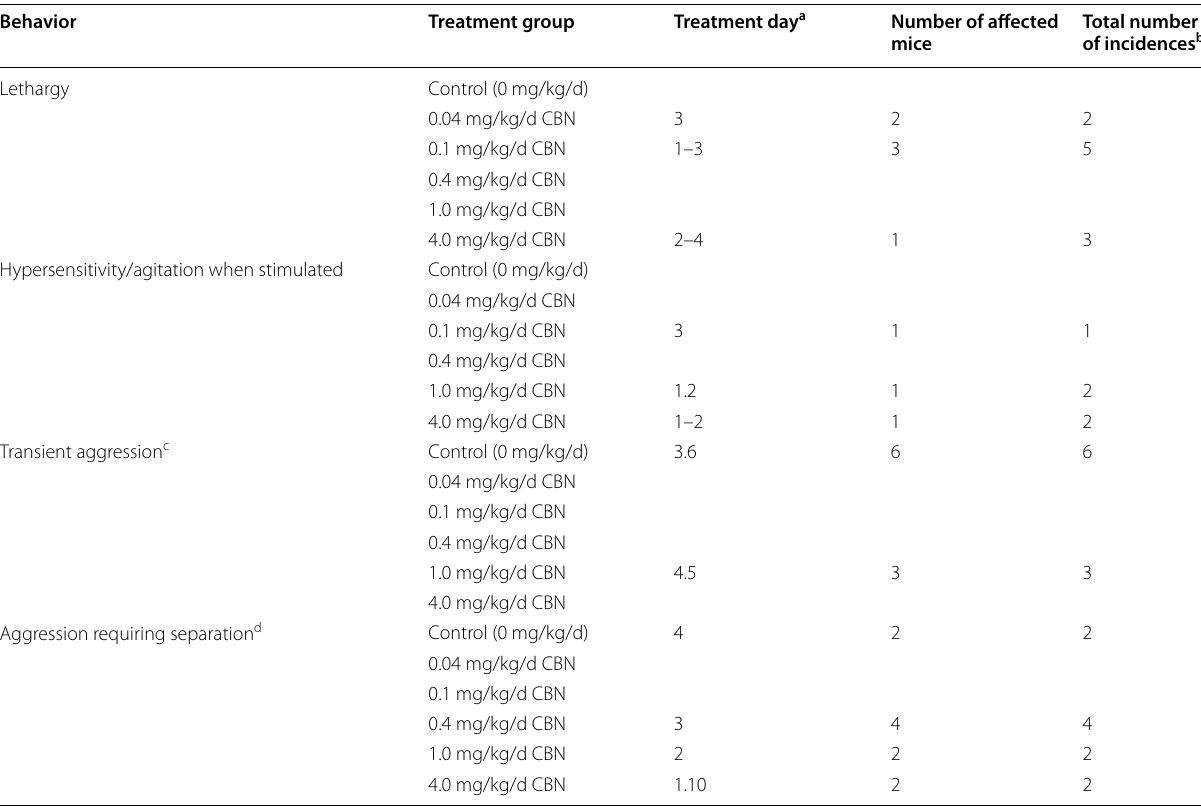
CBN , cannabinol, CBNT CBNight ™ , d day, kg kilogram, mg milligram, SD standard deviation. a Treatment day refers to the days on which the sign was observed. b Total number reflects the fact that some mice had symptoms that resolved and then returned. Each day of each mouse displaying the symptom is counted as 1 incident. c Transient aggression was defined as the observation of fighting between 2 mice that resolved with the observer tapping on the cage to distract the mice. d Separation and subsequent housing were employed when mice continued fighting despite distraction efforts or if multiple incidences of fighting occurred during the observation period